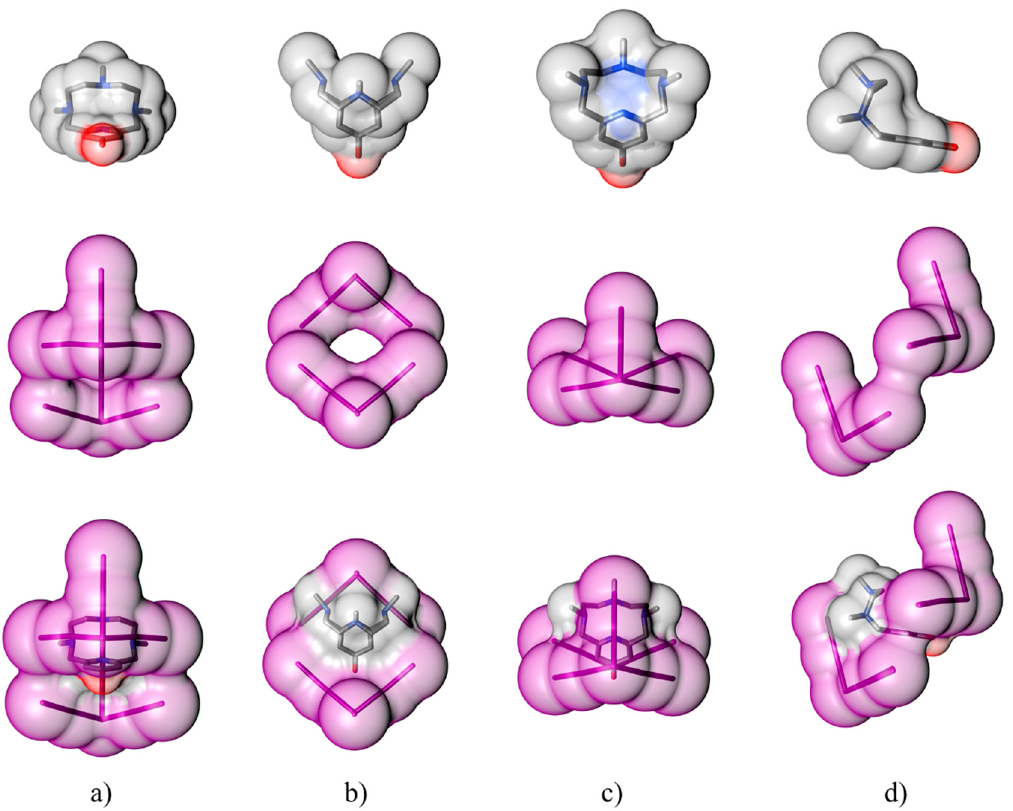
Figure 12. Detailed different views of the H 2 L2–Me 32+ ligand (top), of the two closest non-equivalent interacting I 7 − anions (middle) and of their perfectly complementary complex (bottom), suggesting the templating action of the ligand in orchestrating the selective formation of this polyiodide anion over all the possible others. ( a ) front, ( b ) top, ( c ) back and ( d ) side view of the heptaiodide complex. Color code: grey, C; cyan, N; red, O; violet, I.